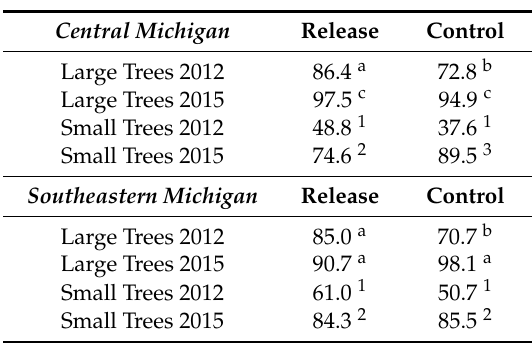
Table 3. Mean proportions of trees exhibiting symptoms of EAB infestation (see text for explanation) for large and small trees in release and control plots in central and southeastern Michigan in 2012 and 2015. Differing superscripts (letters for large trees and numbers for small trees) represent significant differences at α =